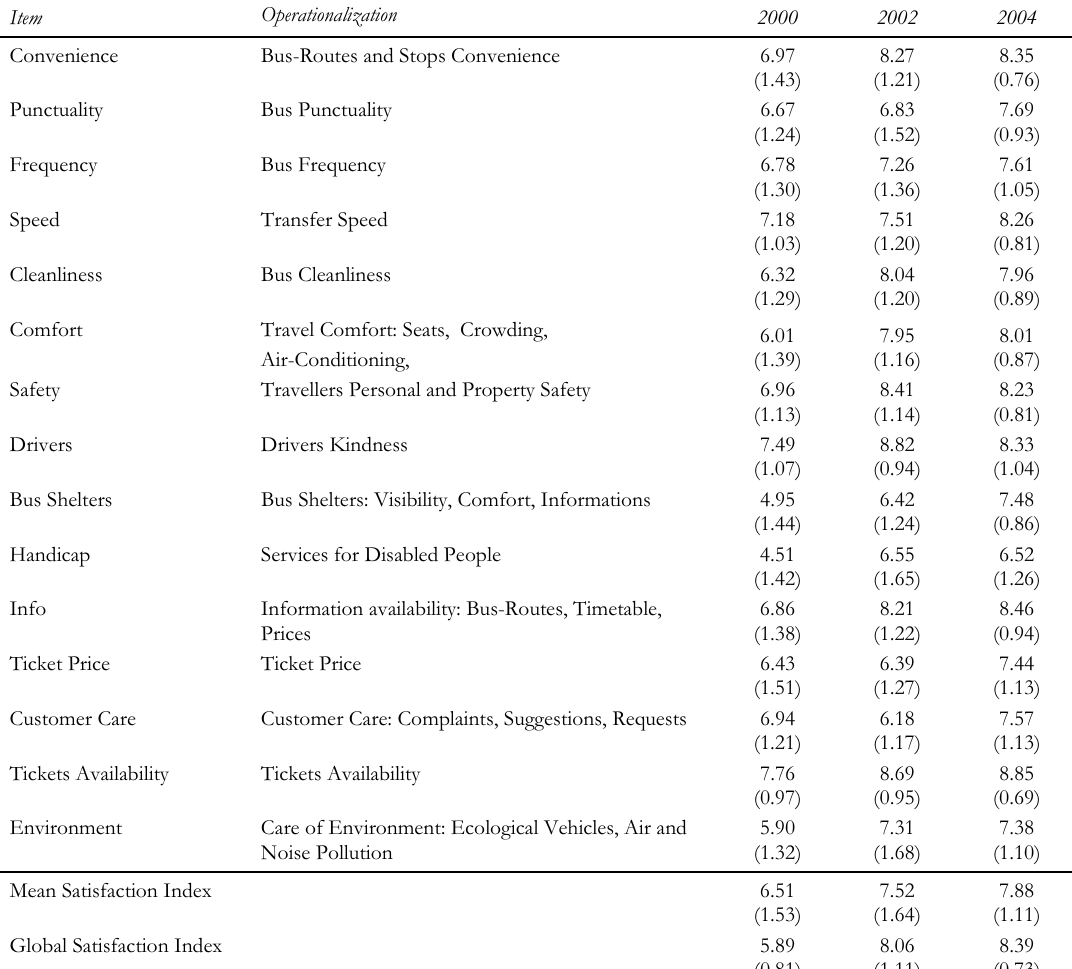
Items descriptions, mean values and standard errors (in